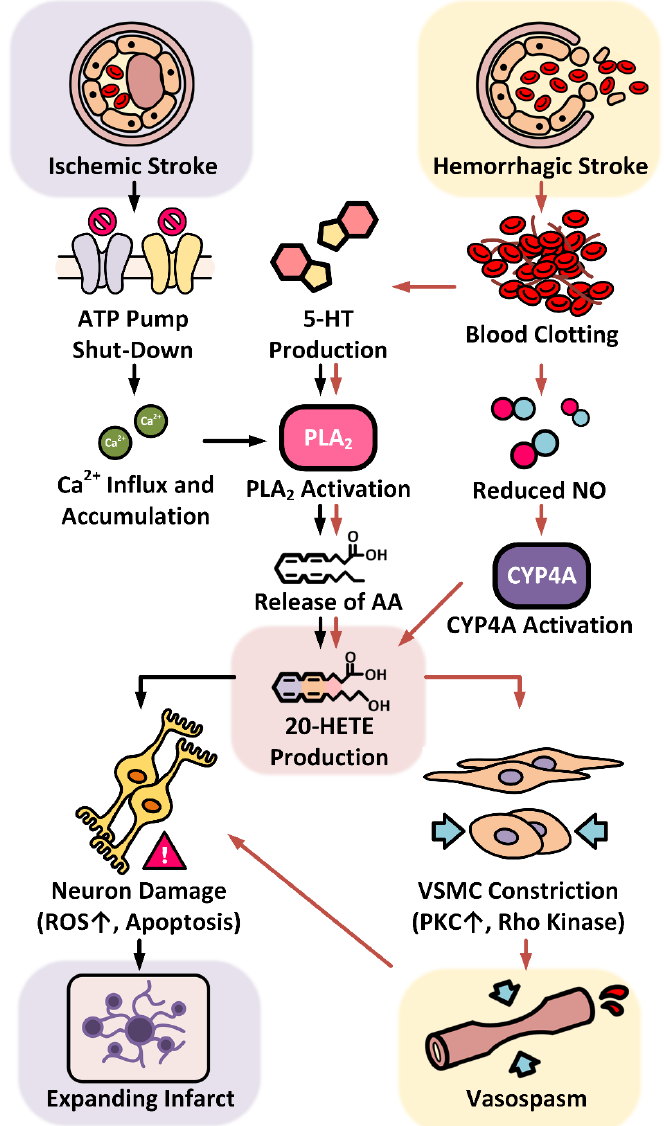
Figure 2. Role of 20-HETE in the progression of ischemic and hemorrhagic strokes. Ischemic stroke leads to hypoxia and ATP depletion, and failure of the ATPase ion pumps within the ischemic core. These e ff ects result in accumulation of intracellular sodium and calcium ions. Enhanced calcium influx activates phospholipase A2 (PLA2) to release arachidonic acid (AA) from the membrane, which is converted into 20-hydroxyeicosatetraenoic acid (20-HETE) by CYP4A enzymes. Clotting blood formed after hemorrhagic stroke releases free hemoglobin and serotonin (5-HT). Free hemoglobin scavenges nitric oxide (NO), and the fall in NO level promotes the activity of CYP4A enzymes. 5-HT stimulates PLA2 and releases AA to increase 20-HETE production. The rise of 20-HETE acts on vascular smooth muscle cells leading to vasospasm, further restricting the blood flow to the stroke site and inducing neuron damage. 20-HETE also a ff ects neurons directly by increasing oxidative stress causing expansion of the infarct after ischemic